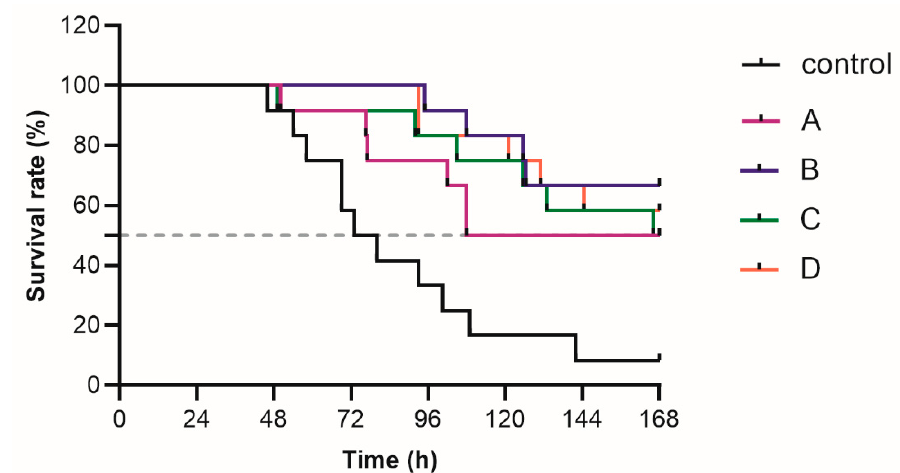
Figure 4. The survival curves of sepsis rats infected with 1 × 10 7 CFU Pseudomonas aeruginosa ATCC9027 and followed with different meropenem regimens attaining various PD targets. A: 75 mg/kg/q6h (40% f T > MIC), B: 75 mg/kg/q2.4h (100% f T > MIC), C: 50 mg/kg/q2.4h (100% f T > MIC), and D: 75 mg/kg/q2h (100% f T > 4 × MIC). Control: sterile saline. Table 2. Statistical results of survival outcomes between meropenem treatment groups and the control in sepsis rat model.